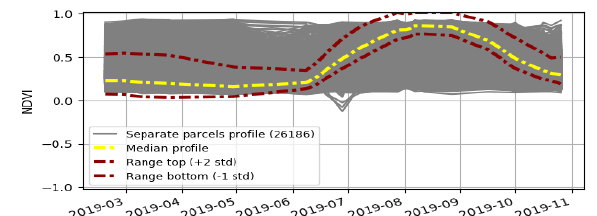
Figure 3. NDVI profiles of Cotton (CTN) parcels for the Sentinel-2 34SEJ tile. The accepted parcels within standard deviation (std) range, above and below the median curve, were 9129 out of 26186. Figure 5. Median NDVI profiles for the accepted parcels of the L2 sub-classes of the Stone Fruit Trees (STN) L1 class from the 34TEL Sentinel-2 tile.